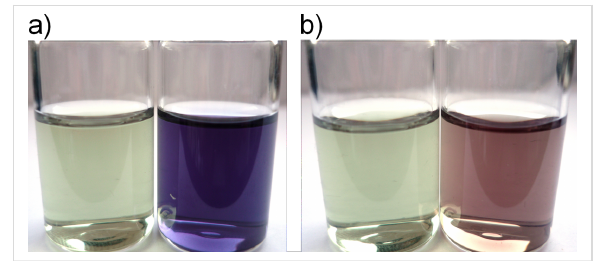
Figure 3: Modified Kaiser test. a) Left: control, right: positive result; b) left: control, control with premature addition of 60% ethanol solution (before solution has fully cooled down and colour has